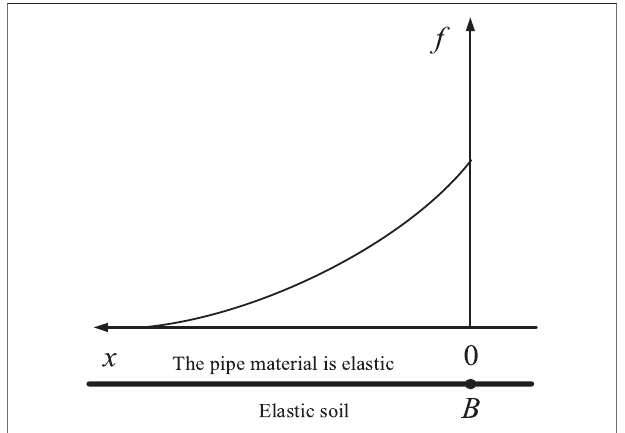
FIGURE 7 | The distribution of soil reaction forces in the tension section of the pipeline at the stage I.